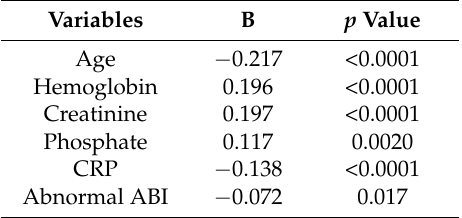
Table 3. Relationship between GNRI and baseline variables by multivariate regression